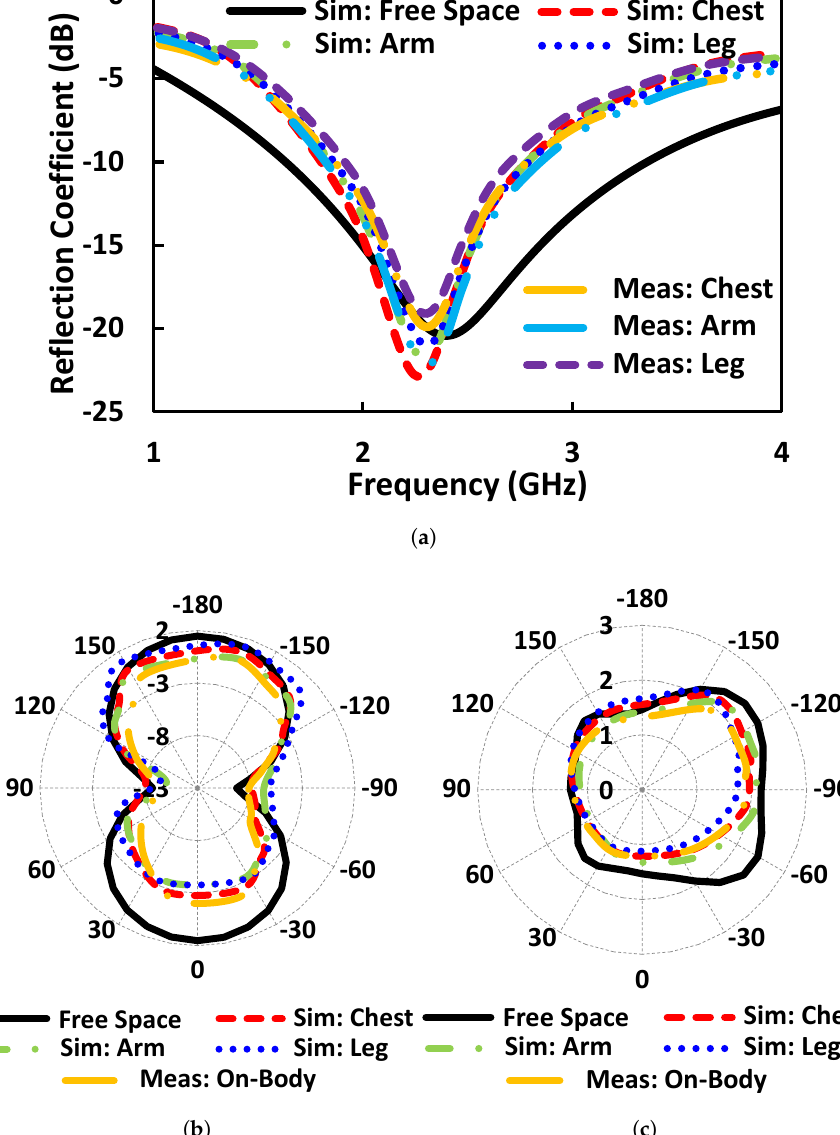
Figure 11. Performance comparison of the antenna in free space and in vicinity of the human body in term of simulated ( a ) reflection coefficient, ( b ) radiation pattern at 0 ◦ , and ( c ) radiation pattern at 90 ◦ . The antenna gain is also one of the diversity parameters. The MIMO antenna gain is a far-field parameter and is measured in an Anechoic chamber using the two standard horn antennas and proposed structure. The simulated and measured gains on the free space and on-body paradigms were carried out as depicted in Figure 12. In the case of our design, the minimum value of the computed and measured peak gain is varied between 2.20 dBi and 2.5 dBi. The simulated antenna gain for the free space and on-body analysis at 2.4 GHz resonant frequency is around 2.49 dBi, while the measured gain in the case of free space and on-body worn at the same band is about 2.20